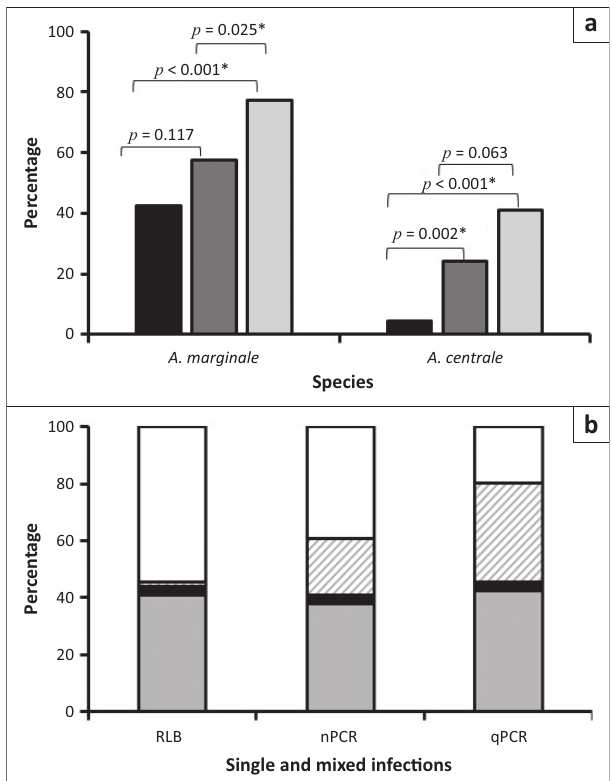
RLB, reverse line blot; nPCR, nested polymerase chain reaction; qPCR, quantitative polymerase chain reaction. * , Indicates significant differences between test results as determined by the Fisher’s exact test ( p ≤ 0.05). FIGURE 4: (a) Detection of Anaplasma marginale and Anaplasma centrale in South African cattle samples ( n = 66) by the reverse line blot hybridisation assay (black), nested polymerase chain reaction (dark grey) and quantitative polymerase chain reaction (light grey). (b) Proportion of single and mixed infections in South African cattle samples as detected by the three assays. Single Anaplasma marginale infection (grey), single Anaplasma centrale infection (black), mixed Anaplasma marginale and Anaplasma centrale infections (hatched), no infection detected (white).